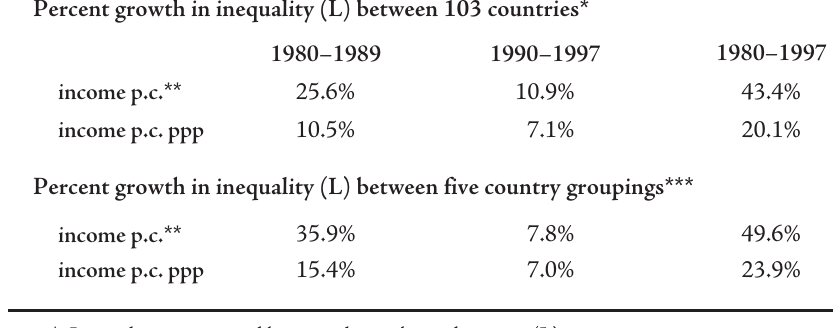
Table 3 – Test of robustness of the increase in inequality in average income levels with regard to different population